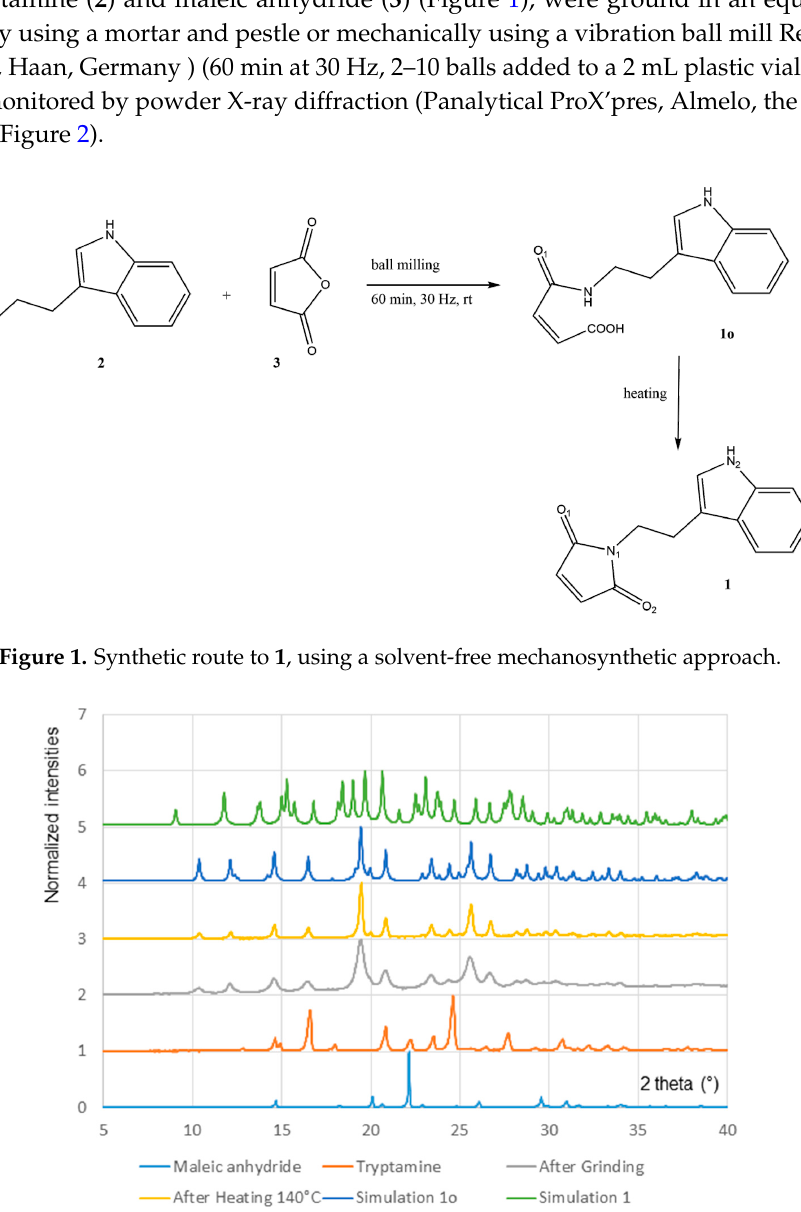
Figure 2. Powder X-ray diffractograms showing the outcome of the grinding experiment. Starting solids (maleic anhydrate and tryptamine), solid obtained after grinding (60 min at 30 Hz), solid obtained after heating (30 min at 140 °C). Diffractograms simulated on the basis of the single crystal structures of 1 and 1o are presented for comparison.